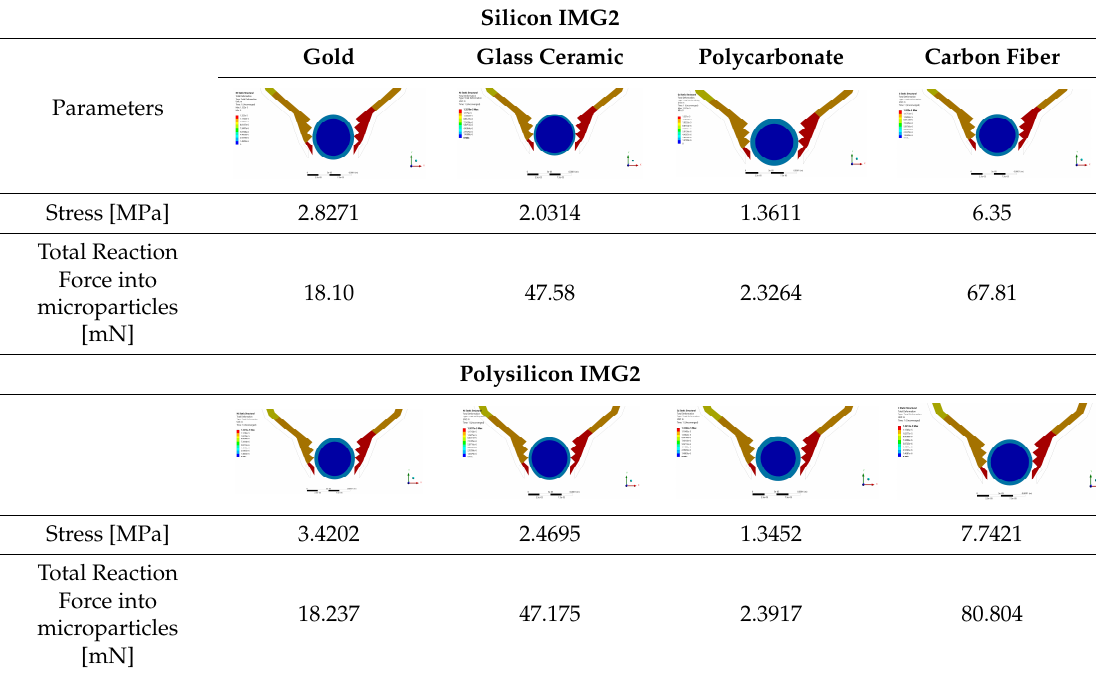
Table 12. Simulation conditions for the manipulation of the microparticles, using Ansys Workbench. Toolbox → Static Structural → Project → Model → Assign materials to items → connections Connections